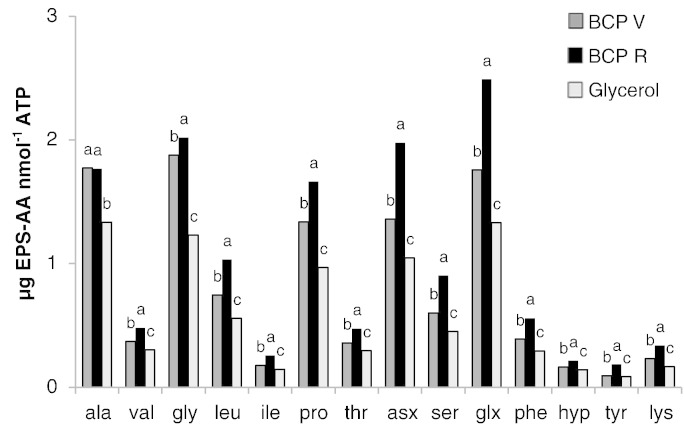
EPS-AA production efficiency. Data are provided on the natural scale. Treatment l.s.d. is calculated from transformed data: efficiency given the same letter is not significantly different (not for comparison between AAs). ANOVA of treatment effect p < 0.001.